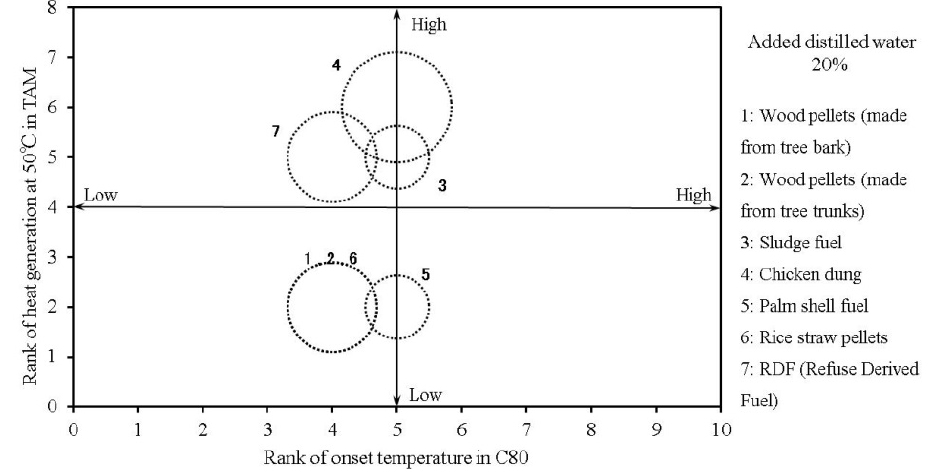
Figure 18. Comparison of risks for onset temperature, heat generation, and flammable gas generation for biomass fuels + distilled water